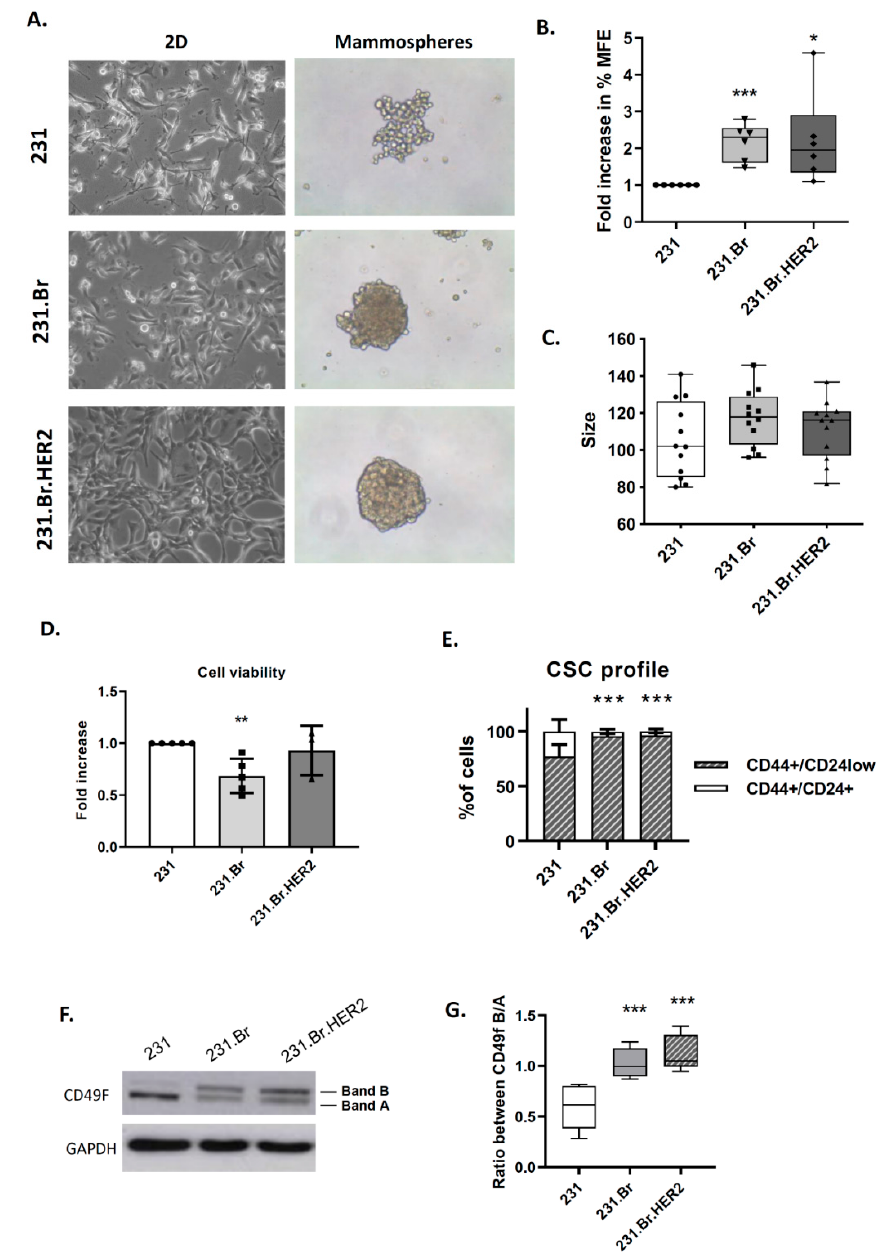
Figure 1. Brain-tropic metastatic breast cancer cells show increased stem cell activity. ( A ) Representative pictures of monolayer (2D) and mammospheres (20 × magnification). ( B ) Fold increase in the % of mammospheres’ formation e ffi ciency (MFE) in brain-tropic cells (231.Br and 231.Br.HER2) compared with parental cells (231). Each dot in the graph represents an independent biological replicate. Both brain-tropic cells showed to have a significant increase in the stem cell activity. ( C ) Size of the mammospheres (spheres > 60 µ m) at the end of the 5-day culture. ( D ) Fold change in cell viability and metabolic activity measured by the Presto blue assay, in brain-tropic cells (231.Br and 231.Br.HER2) compared with parental cells (231). Each dot in the graph represents an independent biological replicate. ( E ) Percentage of cells with the stem cell profile CD44 +/ CD24 − , measured by flow cytometry. ( F ) Western blot for CD49f expression detecting two specific bands ( A and B ). ( G ) Ratio between the upper band ( B ) / lower band ( A ), using pixel density from each band. In all assays 4 to 6 biological replicas were performed. Statistical analysis * p < 0.05, ** p < 0.01, *** p < 0.001.